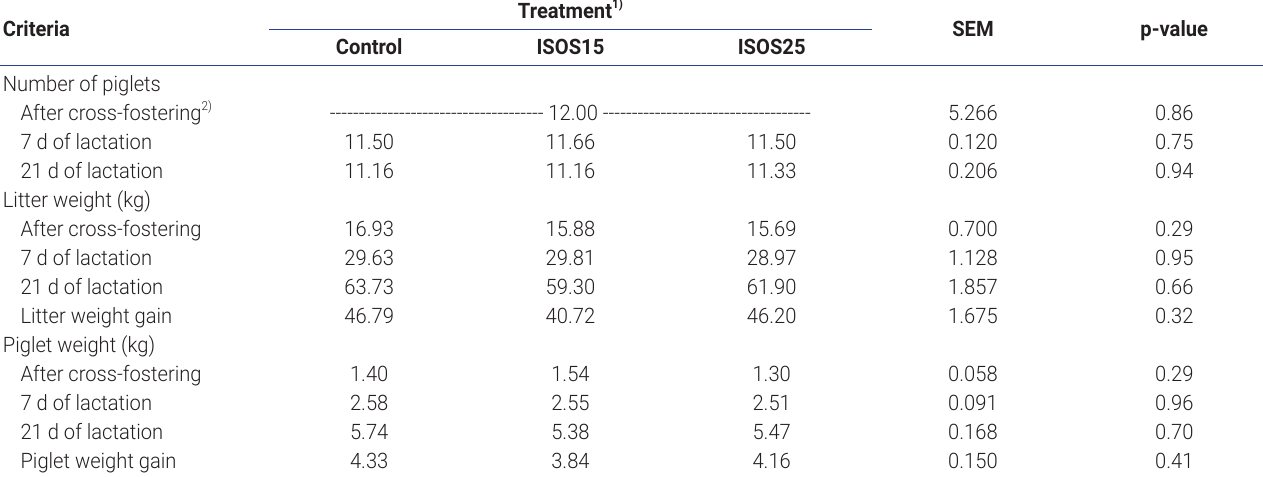
Table 3. Effects of supplemental selenium in the lactation diet on the performance of sows during lactation Criteria